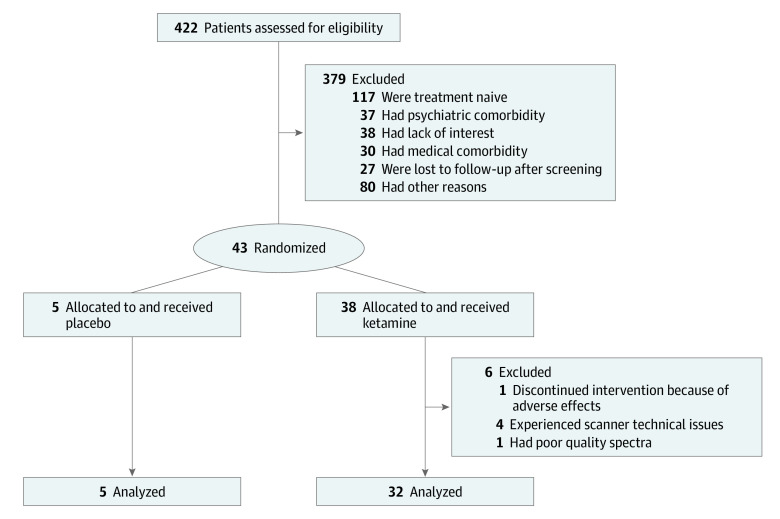
Study Flow Diagram